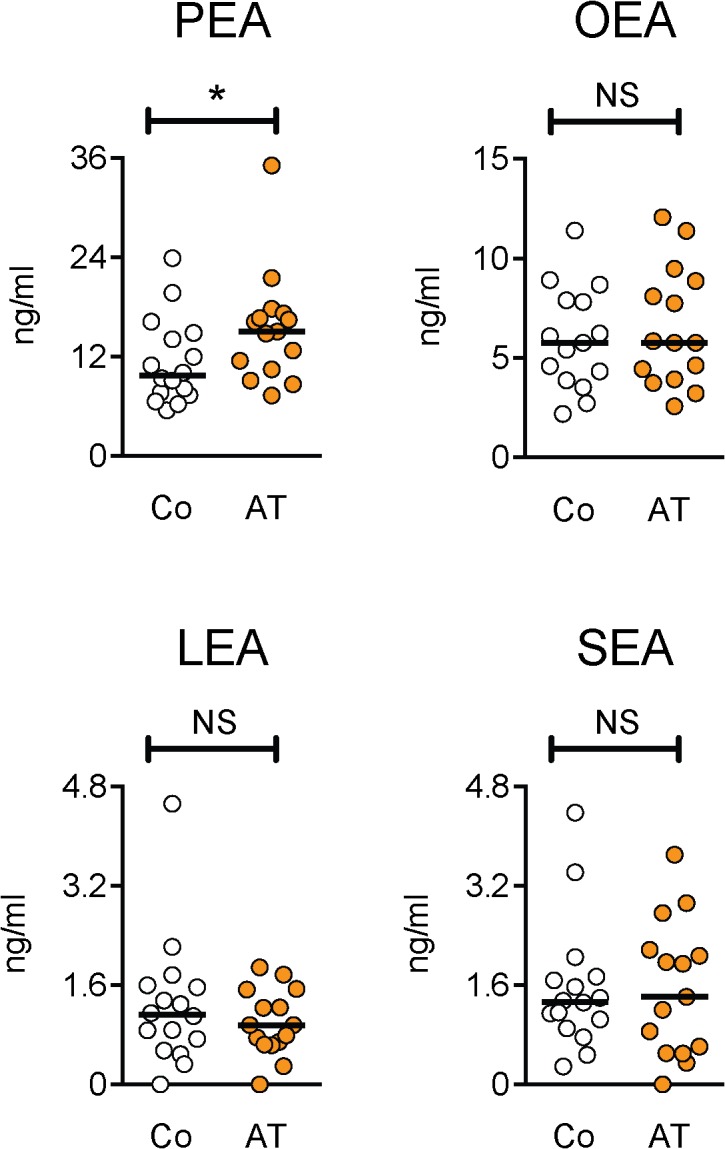
Comparison of N-acylethanolamine levels in control and Achilles tendinopathy serum samples.Co, controls; AT, Achilles tendinosis. Significance levels are from the two-tailed Mann-Whitney U-tests, *P = 0.040; NSP>0.5.